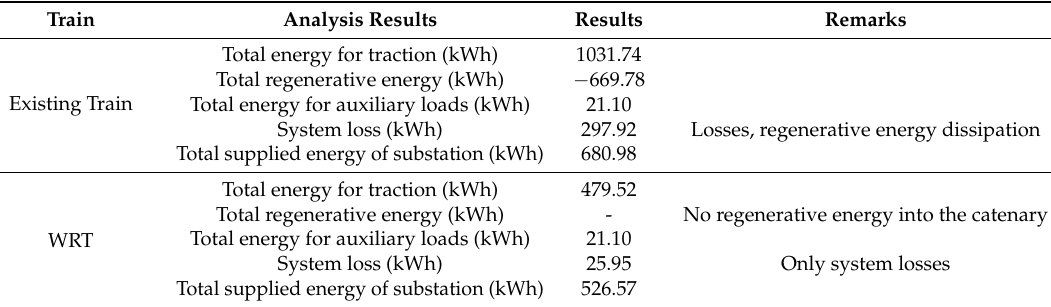
Table 6. Train energy analysis results at non-peak headway